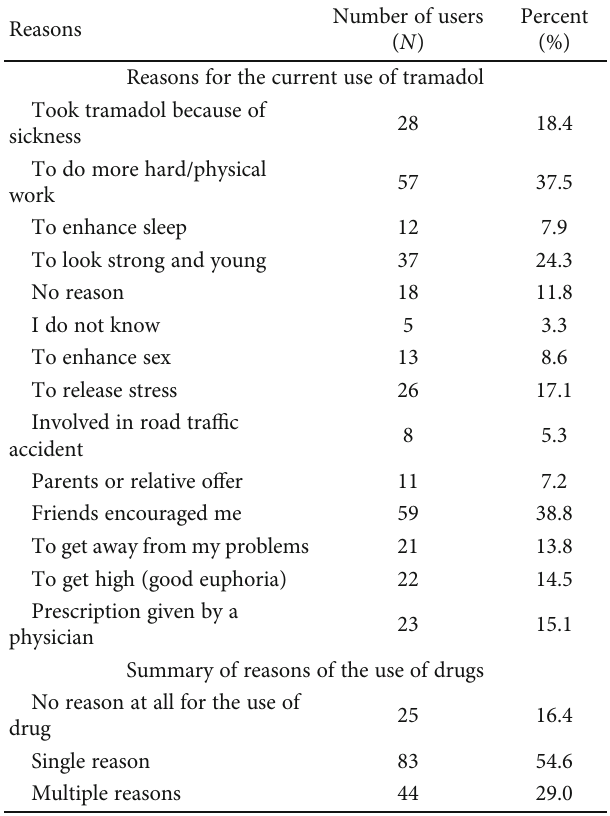
Table 3: Reasons for the intake/misuse of